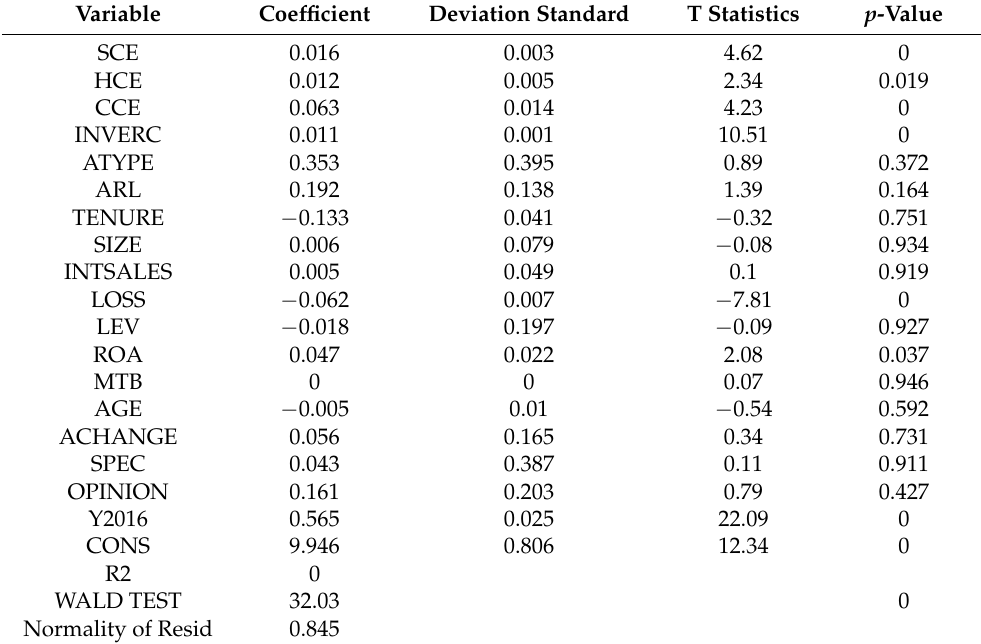
Table 10. The results of estimating the third model by the stochastic effects method.